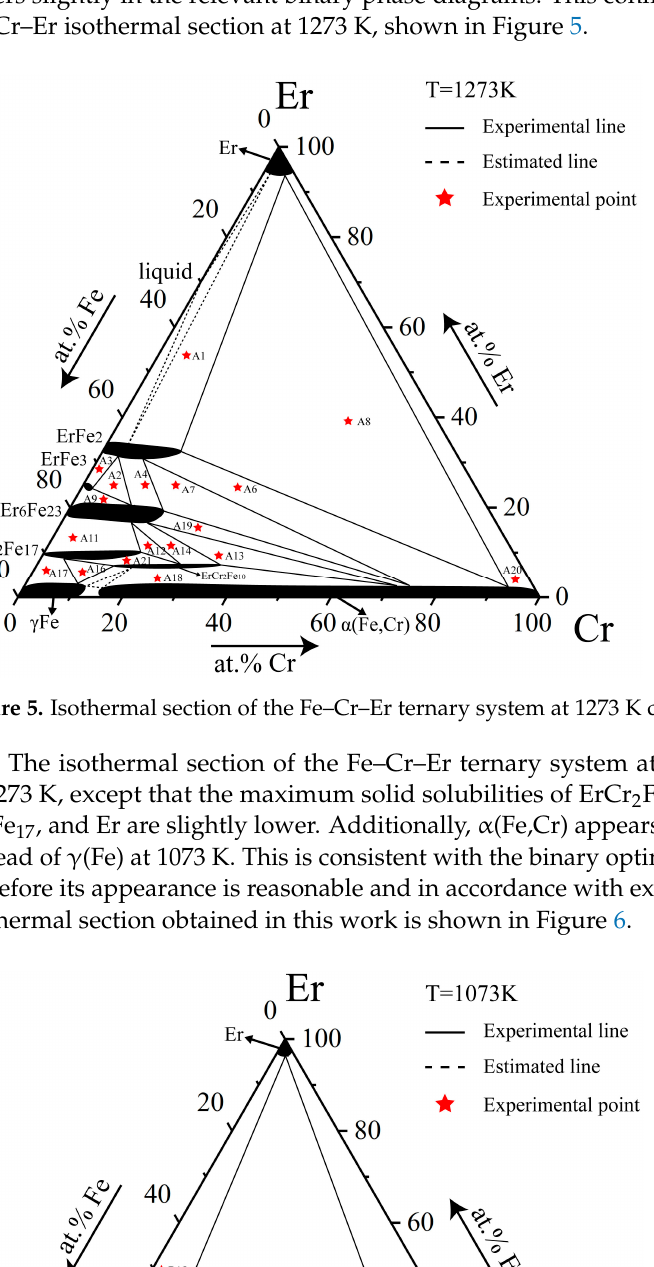
Figure 6. Isothermal section of the Fe–Cr–Er ternary system at 1073 K obtained in this work.